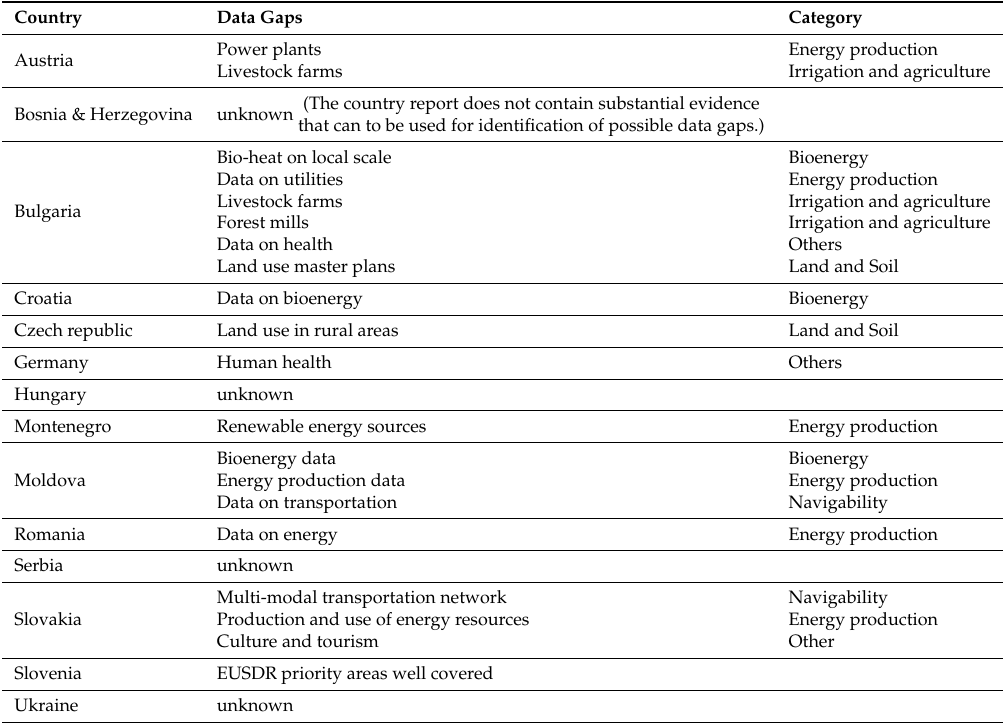
Table 2. List of data gaps in the Danube region. Source: Danube_Net country reports